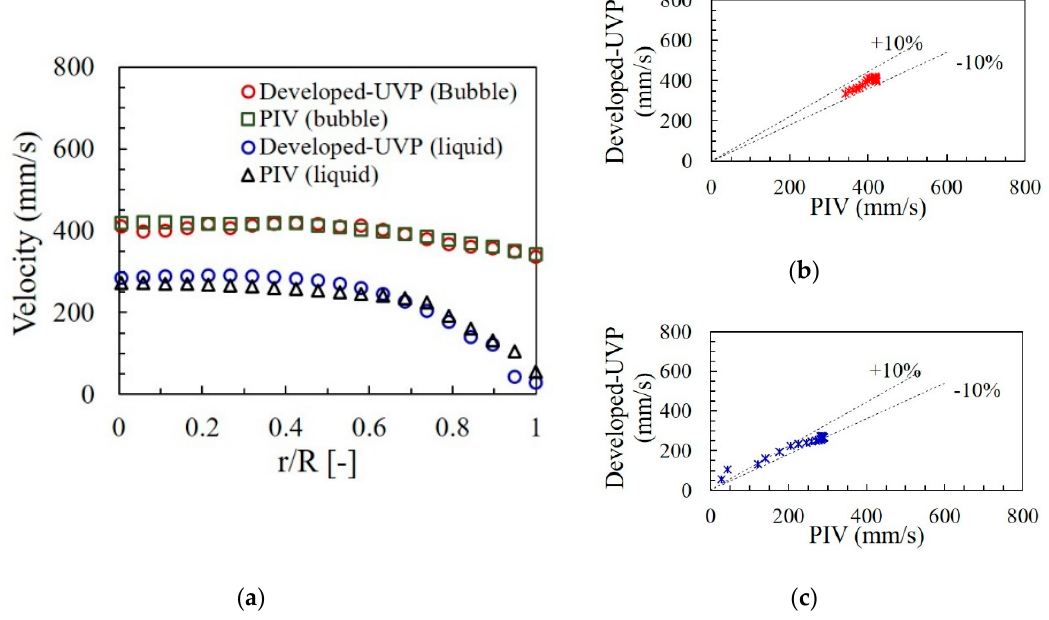
Figure 15. Average liquid and bubble velocity distribution in two ‐ phase bubbly flow at U L = 200 mm/s and U G = 5.3 mm/s: ( a ) velocity profile, ( b ) discrepancy of bubble velocity, ( c ) discrepancy of liquid velocity.